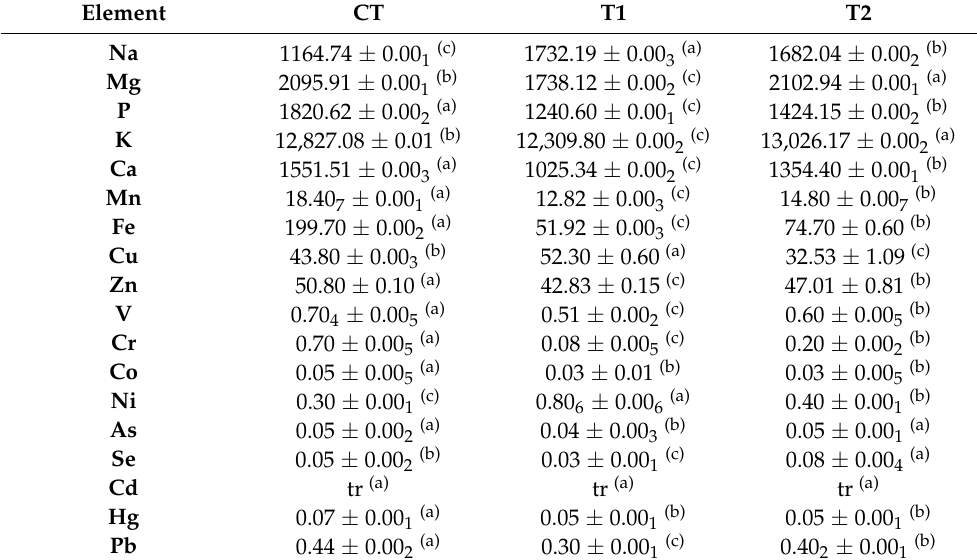
Table 3. Mineral element content (mg kg − 1 ) of olive fruits after treatment with wastewater